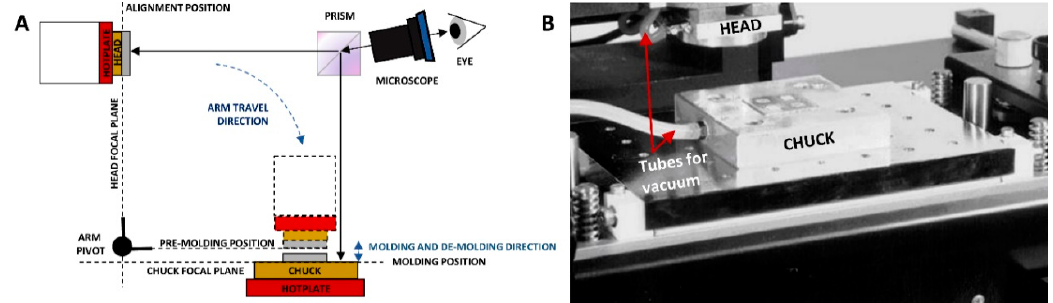
Figure 2. ( A ) Schematic representation of the working principle of the FCM device, used for molding. After alignment of the samples, both fixed to the FCM head and chuck using vacuum, the head is rotated from the alignment position to the pre-molding position, after which it is moved downward into the molding position for molding. After molding, the head is moved back up into the pre-molding position and subsequently rotated into the alignment position. ( B ) Picture of the FCM device, including the head, chuck and tubes for vacuum. Adapted with permission from [30].